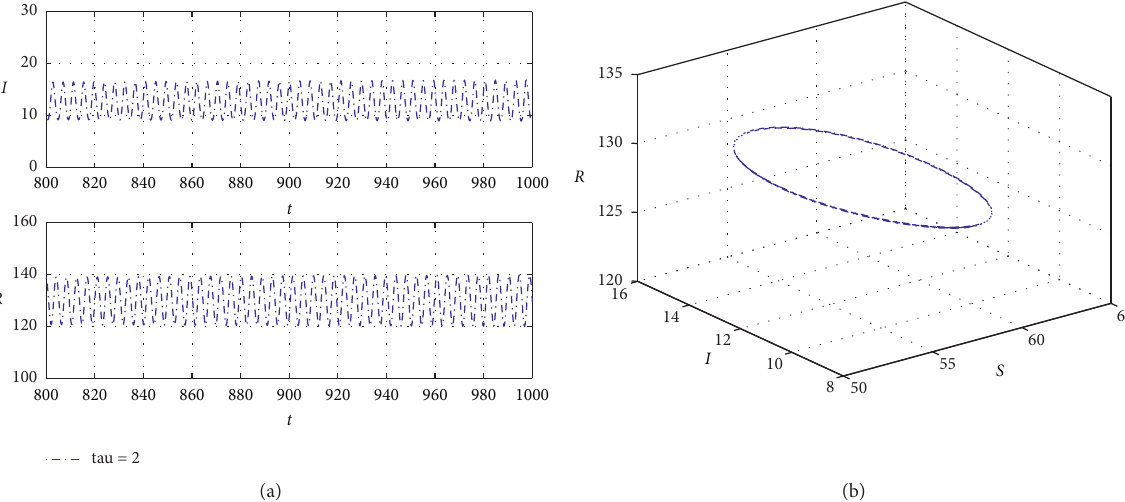
Figure 5: The hopf bifurcation around the computer virus equilibrium E